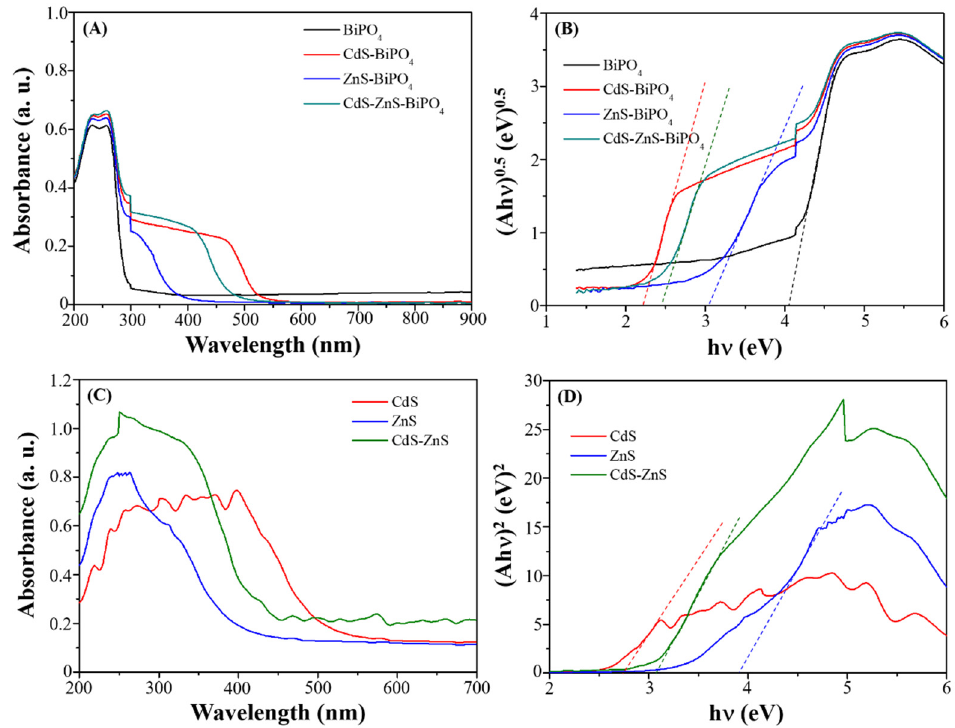
Figure 3. ( A ) UV-vis DRS spectra and ( B ) (Ah ν ) 0.5 versus h ν curves of BiPO 4 (black), CdS-BiPO 4 (red), ZnS-BiPO 4 (blue), and CdS-ZnS-BiPO 4 (olive) composites. ( C ) UV-vis DRS spectra and ( D ) (Ah ν ) 2 versus h ν curves of CdS (red), ZnS (blue), and CdS-ZnS (olive) nanoparticles.